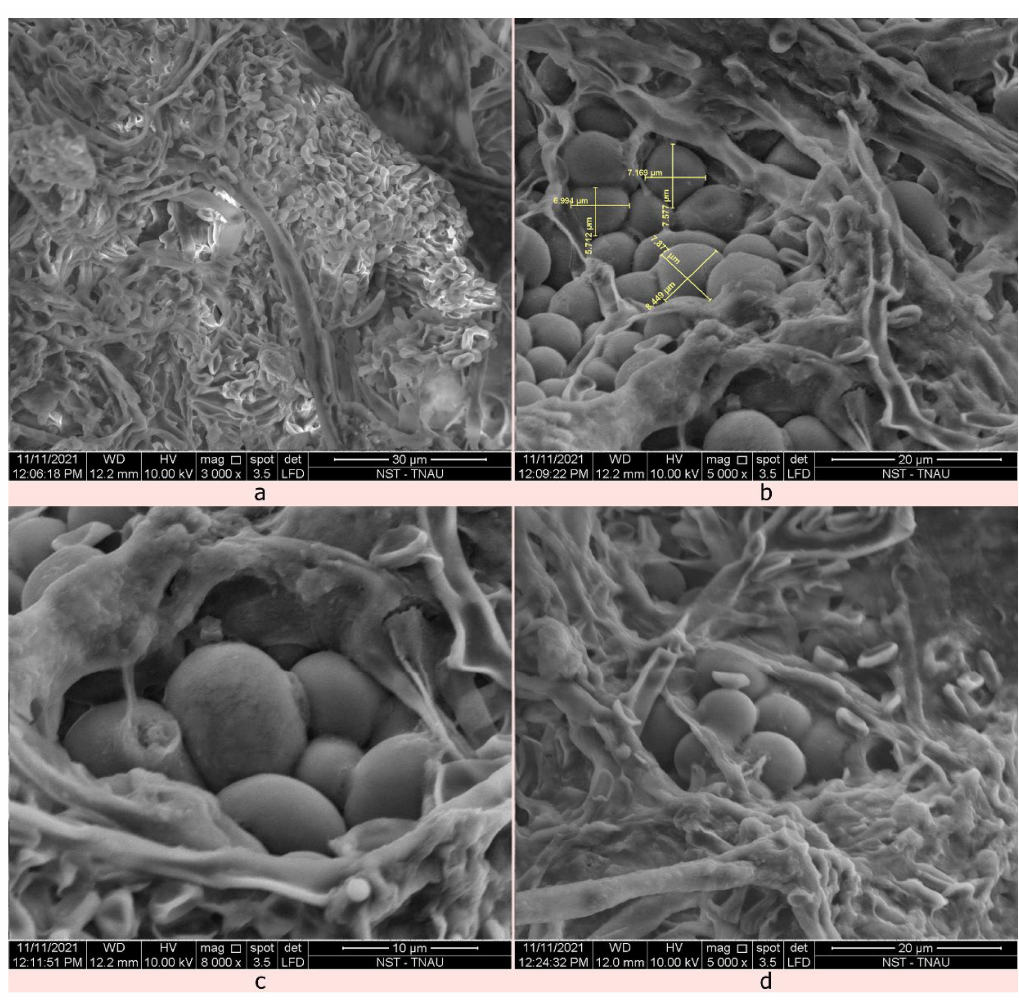
Figure 5. SEM images of C. rosea interaction over the sclerotia. ( a ) Presence of numerous conidiospores surrounding the outer sclerotial wall (3000 × magnification; 30 µ m). ( b ) A closer view of the C. rosea conidia wall (5000 × magnification; 20 µ m). ( c ) The development of appressoria-like spore attachment structures (8000 × magnification; 10 µ m). ( d ) Spore contact at the cortex layer of the sclerotia (5000 × magnification; 20 µ